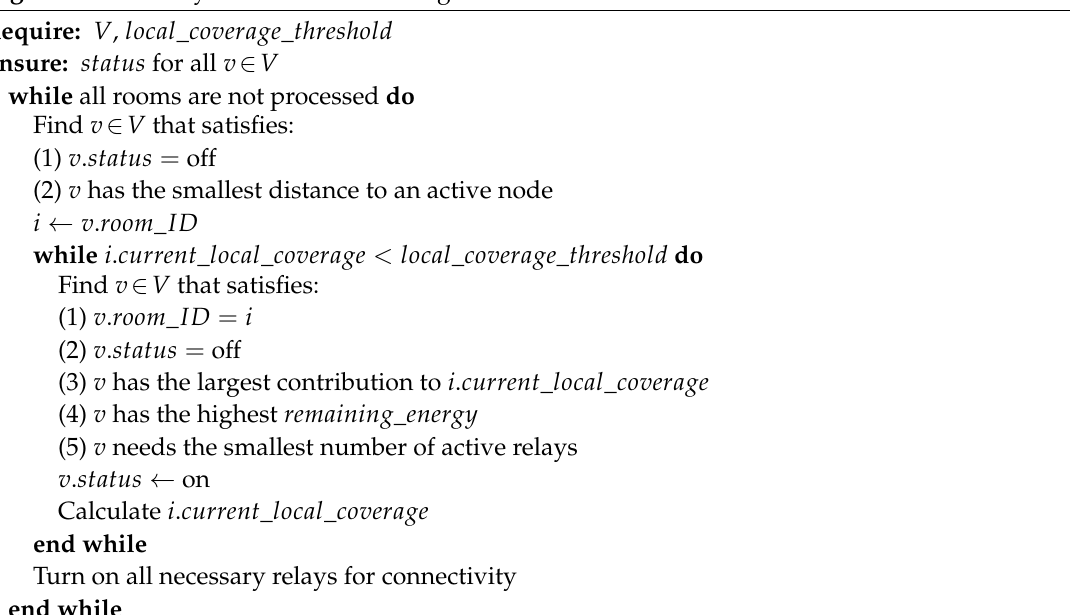
Algorithm 1 Greedy initial network